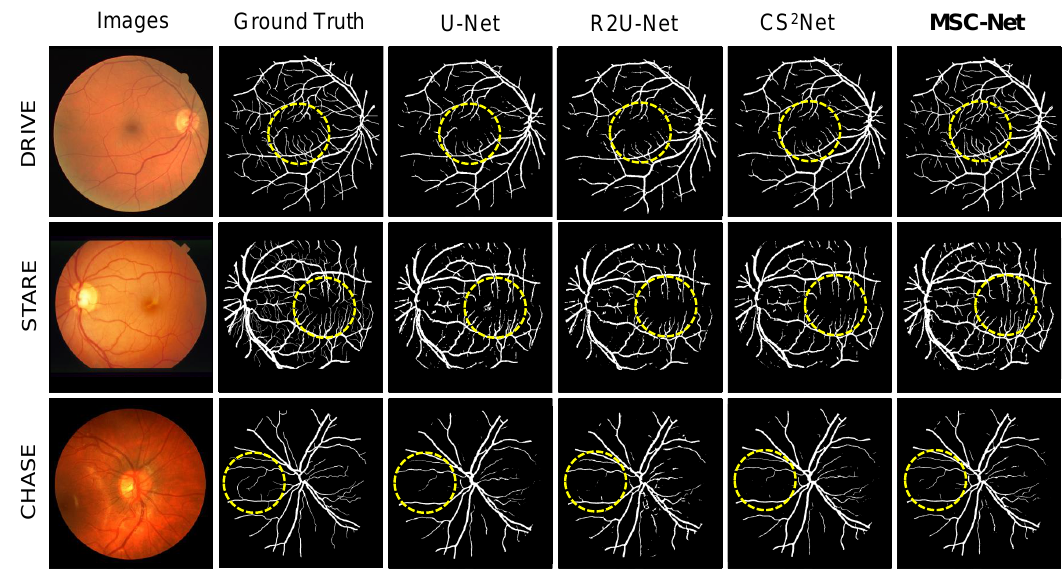
Figure 4. Visualization results of different blood vessel segmentation methods. The segmentation contained in the yellow dashed circle is our concern. Our method has better results in small parts.